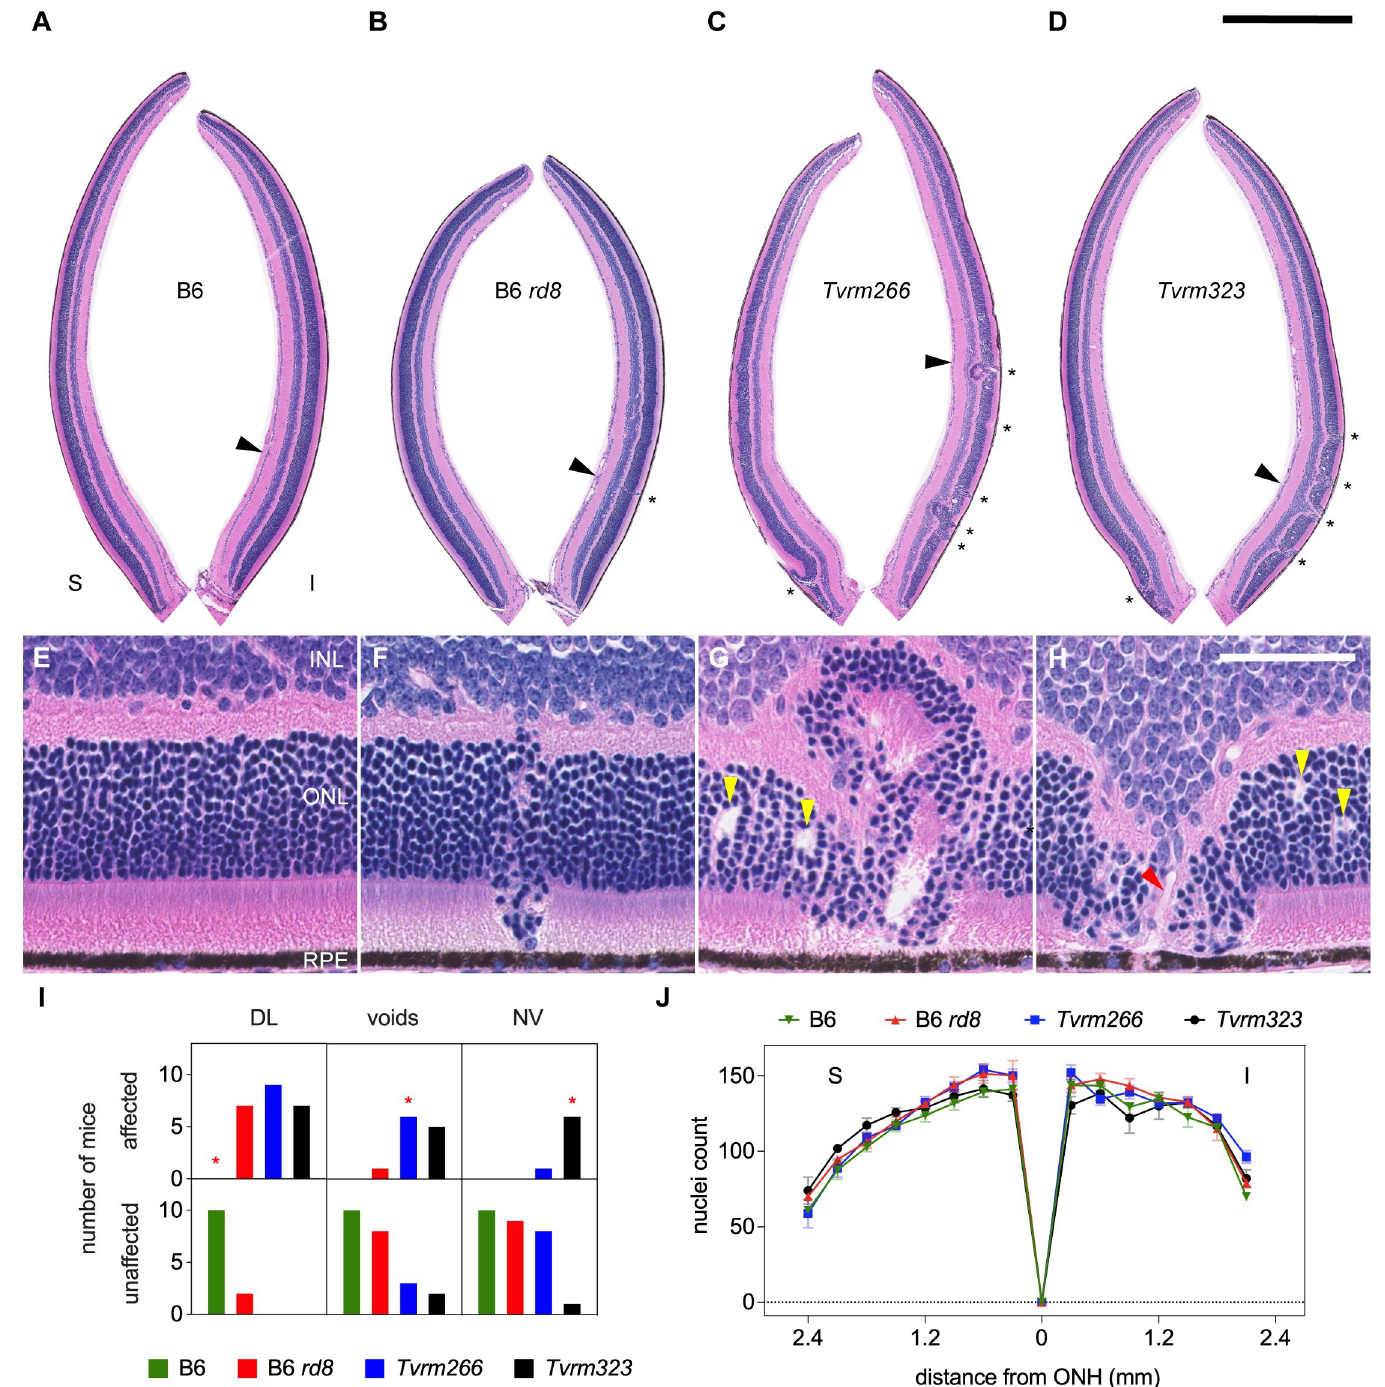
Fig 4. Histological analysis at one month of age. A–D. Superior (S) and inferior (I) retinas cropped from digital images of B6, B6 rd8 , Tvrm266 and Tvrm323 whole eye sections stained with hematoxylin and eosin and imaged with a slide scanner. Dysplastic lesions, asterisks . Scale bar, 0.5 mm. Sites from A-D detailed in panels E–H, respectively, are marked by arrowheads . E. Normal retinal layers in B6 mice. INL, inner nuclear layer; ONL, outer nuclear layer; RPE, retinal pigment epithelium. F–H. Dysplastic lesions in B6 rd8 , Tvrm266 , and Tvrm323 mice, respectively. Voids in panels G and H, yellow arrowheads . H. Lesion containing possible vascular structure, red arrowhead . Scale bar, 50 μ m; applies to E–H. I. Incidence of pathological features. Mice showing one or more of the identified features among 17–21 reviewed histological sections were scored as affected. Asterisks denote statistical significance (Fisher’s exact test against B6 rd8 mice, p < 0.05). DL, dysplastic lesions; NV, neovessels. J. Photoreceptor nuclei count within a 50 μ m length of retina as a function of distance from the ONH. Values represent mean ± standard error of the mean (SEM); n = 5–8.